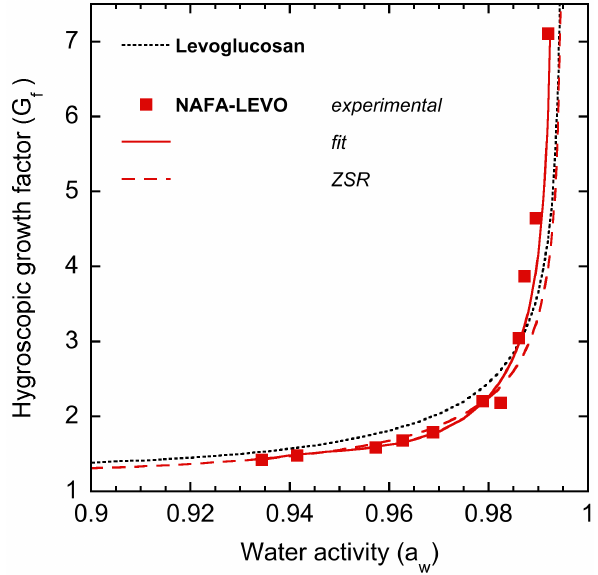
Fig. 5. Hygroscopic growth factor as a function of water activity for pure substances at 25 ◦ C. Open symbols show the growth factors calculated from data measured by Zamora et al. (2011). Solid lines represent fits to the data based on the water activity parameteriza- tions presented in Table 1, while vertical dashed lines denote the deliquescence a w value. The deliquescence measured for NAFA or Fluka HA was above a w = 0 . 999; therefore G f = 1 for these humic substances (HS) below this value.